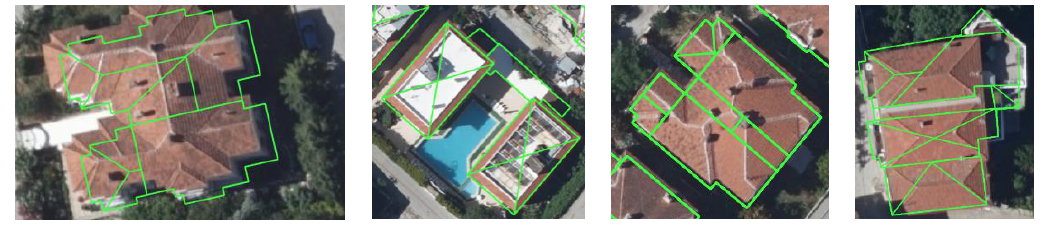
Figure 20. Examples to the false reconstructions of the roofs.